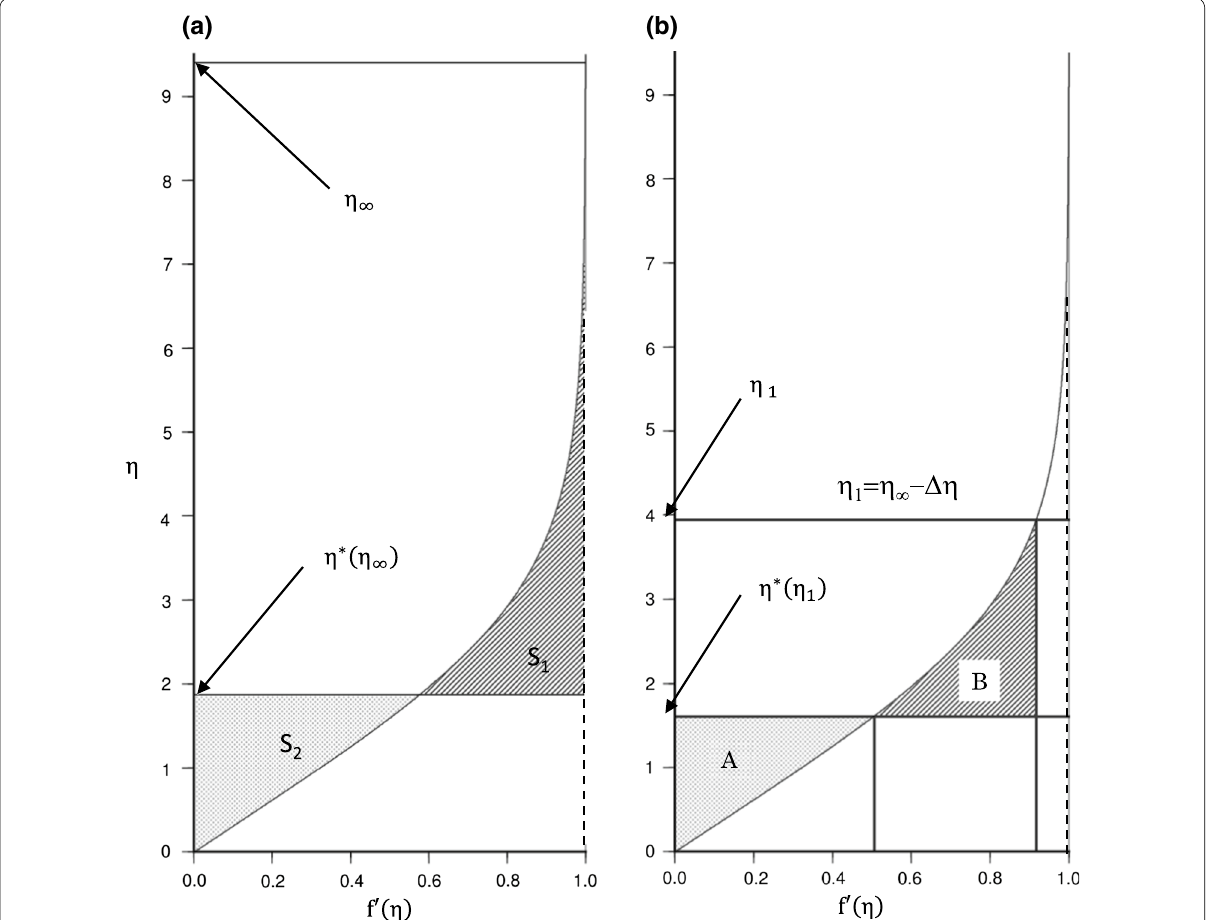
Fig. 4 a Definition of the displacement thickness, η *( η displacement distance, η *( η 1 ), for the flow rate profile of the laminar boundary layer for areas B